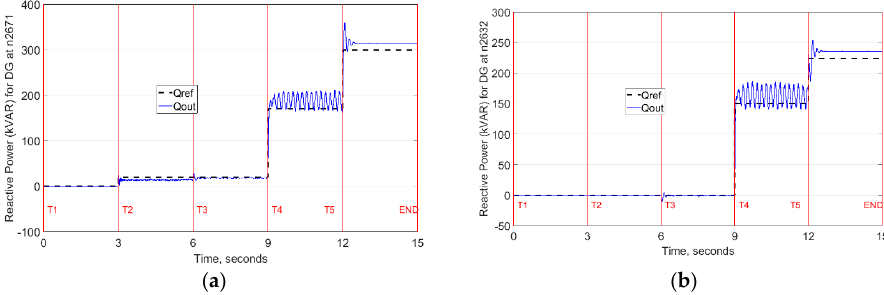
Figure 17. Droop reference reactive power and output reactive power for DGs at nodes ( a ) 2671 and ( b ) 2632 as obtained from PSCAD simulation.